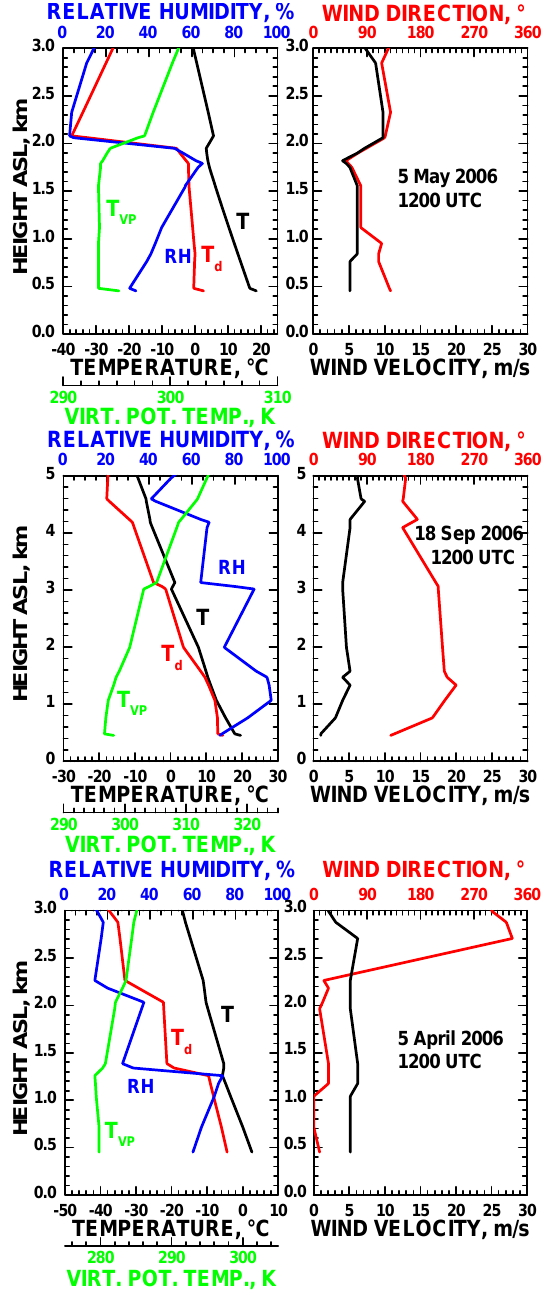
Fig. 2. 12:00UTC Meiningen (50.6 ◦ N, 10.4 ◦ E, 450ma.s.l.) ra- diosonde profiles of temperature T , virtual potential temperature T VP , dew point T d , and relative humidity RH . The sondes are routinely launched by the German Meteorological Service 170km southwest of Leipzig.